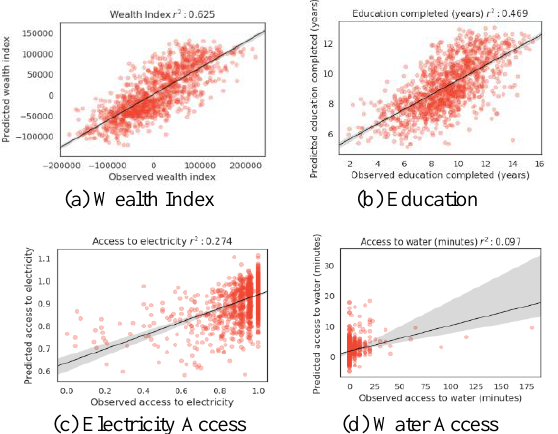
Figure 4. Ground-truth wealth index and cross-validated Philippine poverty predictions using the satellite-based deep learning model.